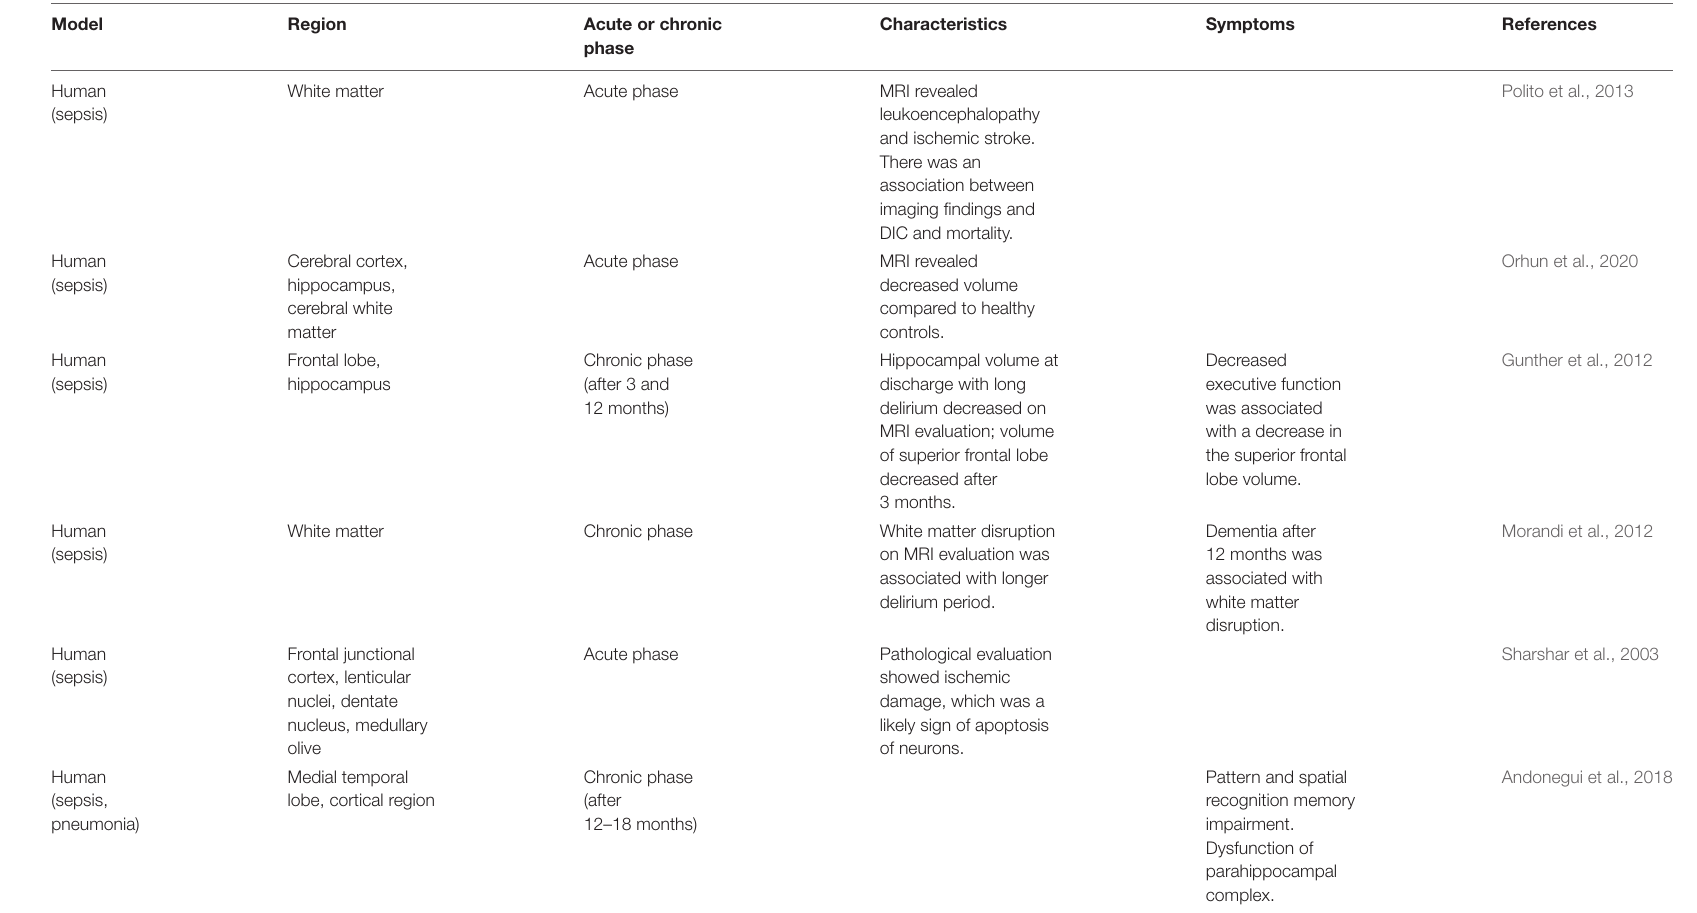
TABLE 1 | Brain dysfunction in patients with